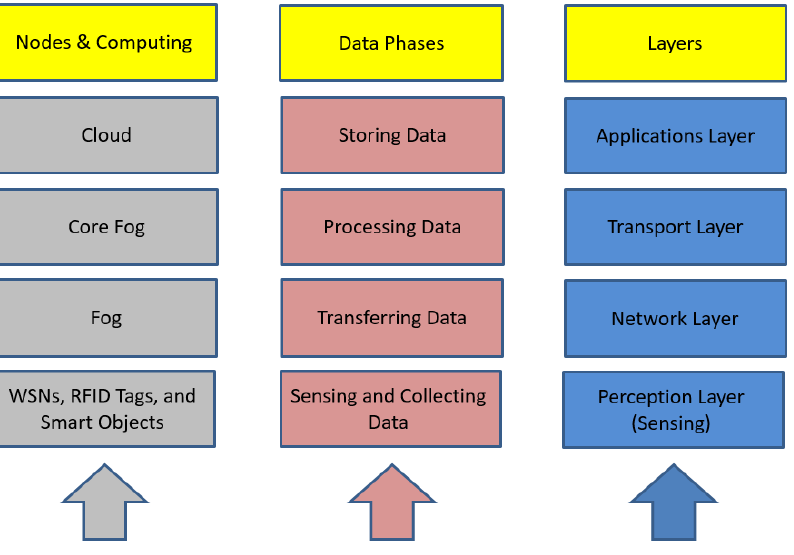
Figure 3. IoT layers and phases.